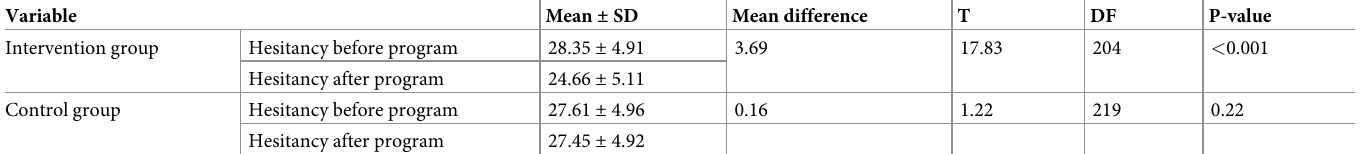
Table 3. Hesitancy of getting the vaccine before and after the program.